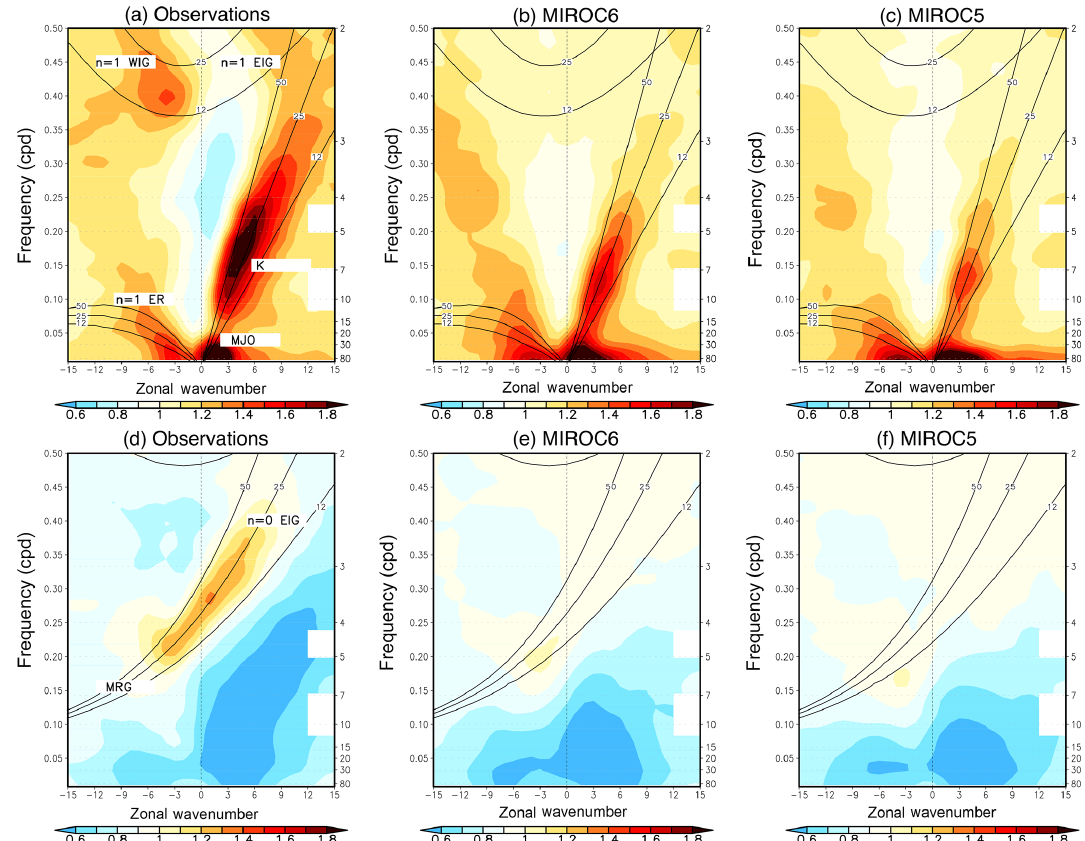
Figure 20. Zonal wavenumber–frequency power spectra of the (a–c) symmetric and (d–f) antisymmetric component of OLR divided by background power in (a, d) observations (NOAA OLR), (b, e) MIROC6, and (c, f) MIROC5. Dispersion curves of equatorial waves for the three equivalent depths of 12, 25, and 50m are indicated by black lines. Signals corresponding to the westward and eastward inertia– gravity (WIG and EIG) waves, the equatorial Rossby (ER) waves, equatorial Kelvin waves, the mixed Rossby–gravity waves (MRG), and Madden–Julian oscillation (MJO) are labeled in (a) . The unit of the vertical axes is cycles per day (cpd).